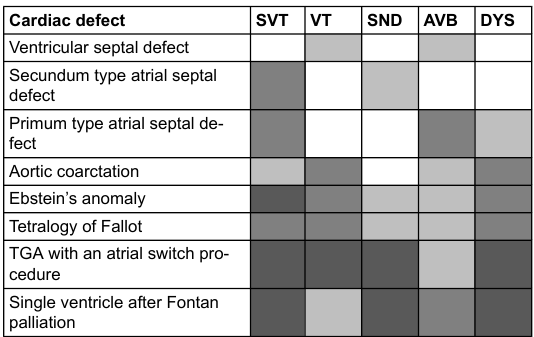
Table 4: Frequency of rhythm problems in GUCH